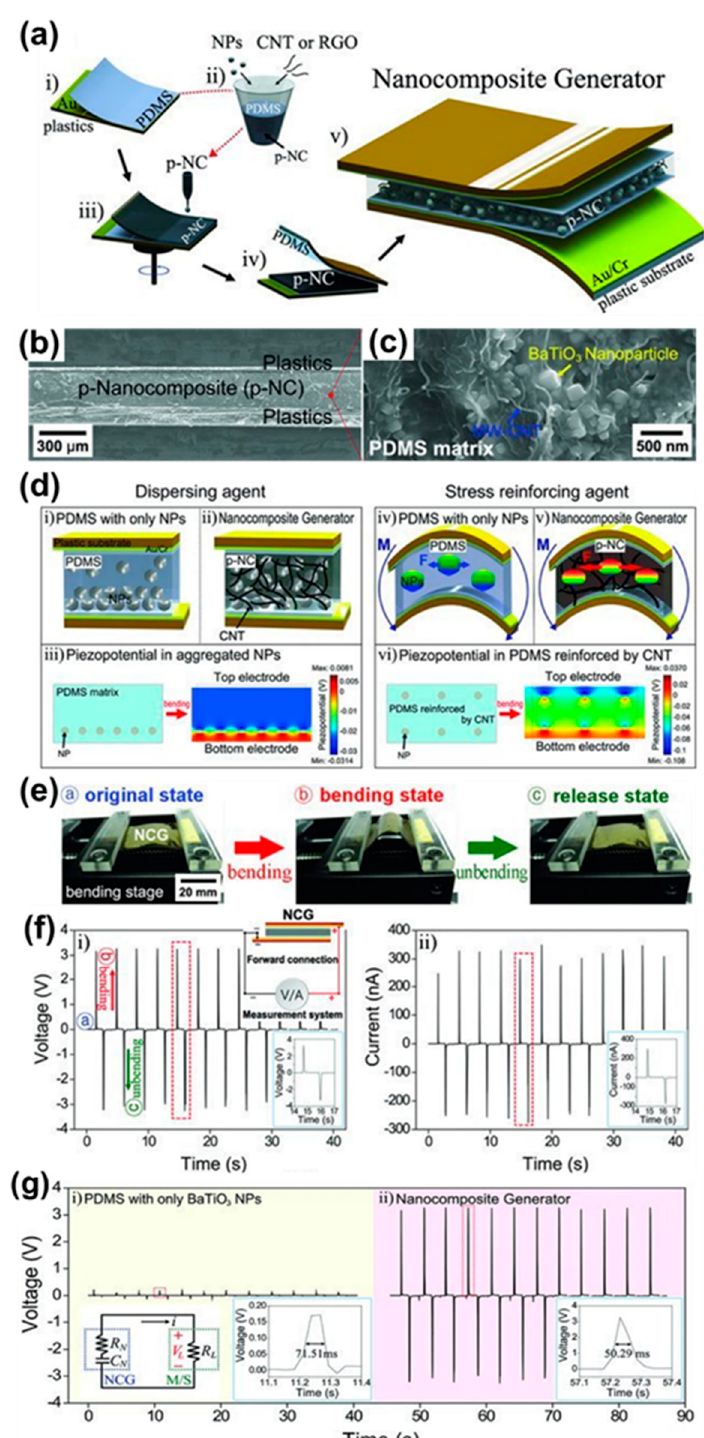
Figure 2. ( a ) Schematic diagram of the fabrication process for NCG device. ( b ) Cross − sectional SEM image of NCG device. ( c ) Magnified cross − sectional SEM image of the piezoelectric nanocomposite. ( d ) Schematic illustration of the cross − sectional structure of NCG device and estimated piezoelectric distributions for investigating the role of CNTs as ( i – iii ) a dispersing agent and ( iv – vi ) a stress reinforcing agent. ( e ) Photographs of NCG device in original, bending and release states. ( f ) Voltage and current response of NCG device in forward connection. ( g ) Voltage response of a device containing only BT NPs and a NCG device. The bottom-left inset of indicates the equivalent circuit diagram of NCG device. The bottom-right insets indicate the magnified voltage response by the mechanical bending motion. Reproduced with permission [29].